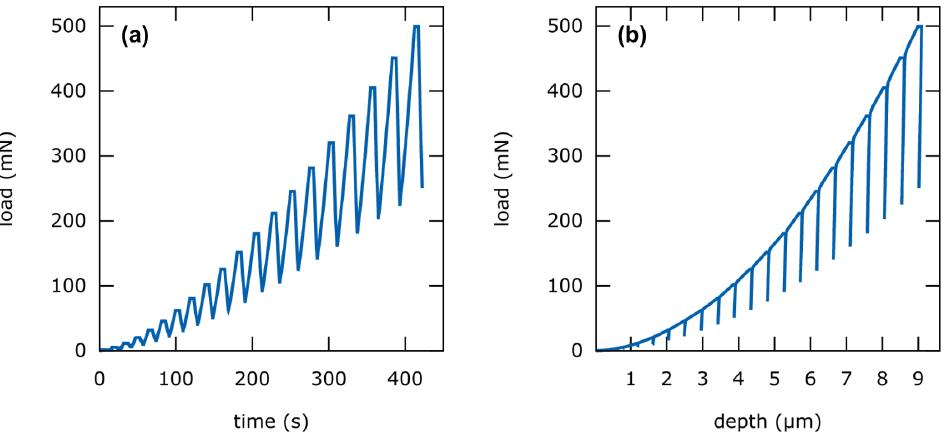
Figure 3. Exemplary curves of an ESP-application. ( a ) programmed load-time-curve. ( b ) resulting load-depth